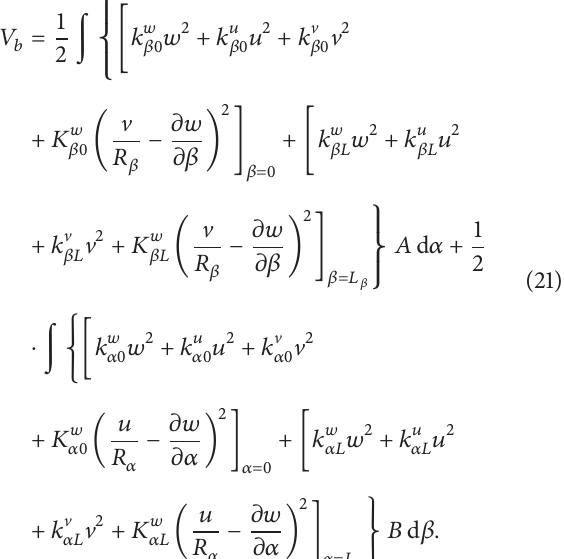
Thus, the total potential energy of the spring